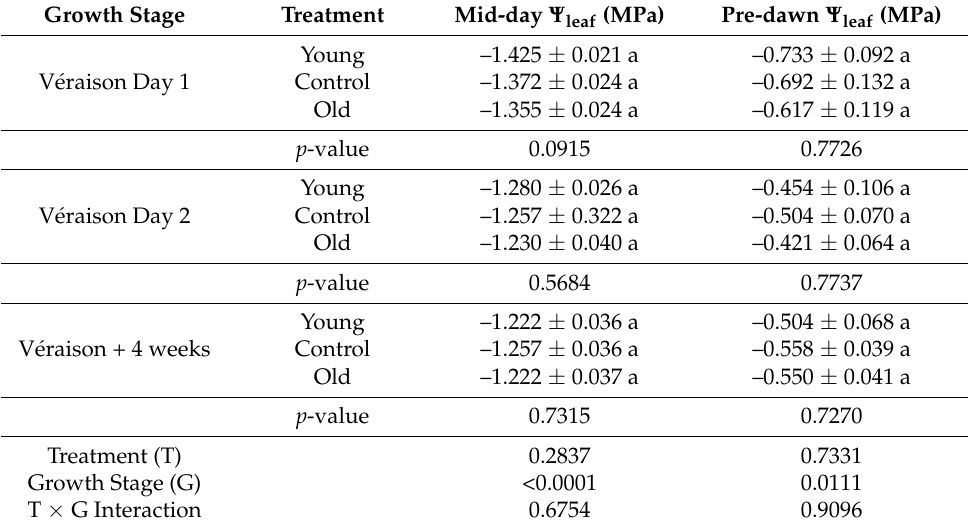
Table 5. Two-way analysis of variance (ANOVA) with interaction showing pre-dawn and mid-day leaf water potential ( Ψ leaf ) measurements by treatment and growth stage during the 2020 growing season ( n = 6 and n = 15, respectively). V é raison + 4 corresponds to four weeks post-v é raison. Treatment means followed by standard error of the mean. Different letters indicate significant differences between treatment groups based on Tukey HSD. Significant p -values (<0.05) are shown in the